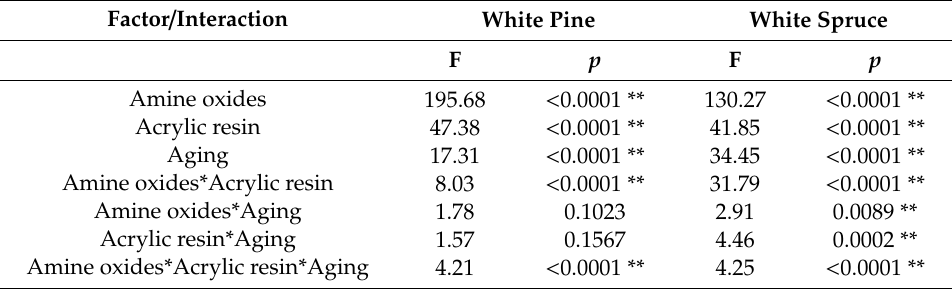
Table 8. F ratio and p values of the statistical analyzes for the adhesion test. Factor / Interaction White Pine White Spruce